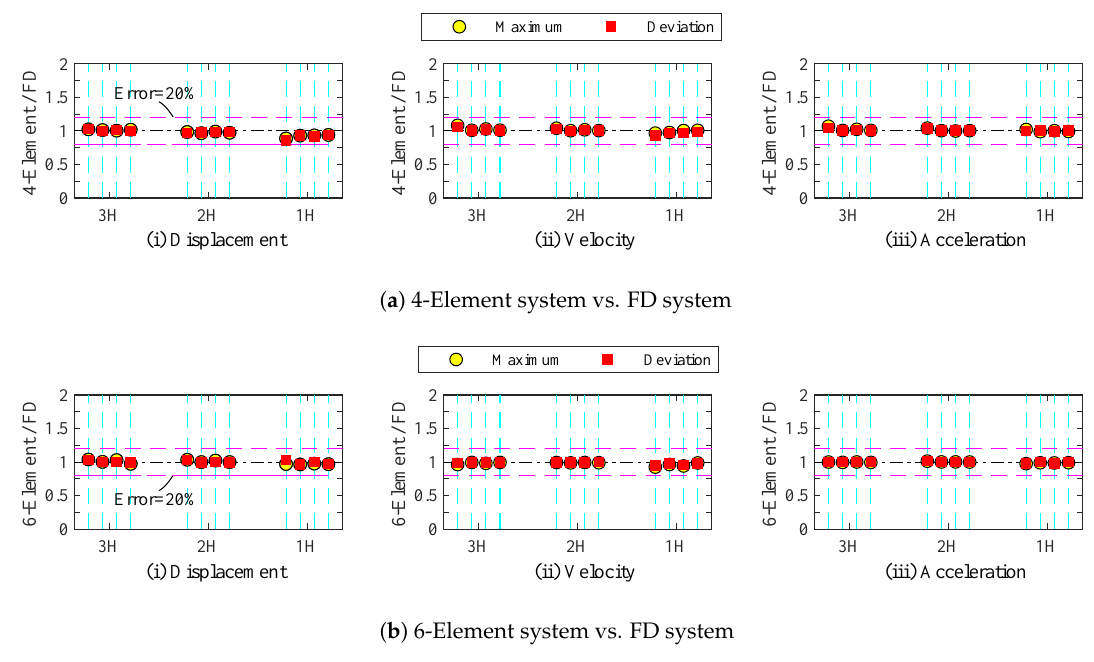
Figure 24. Ratio of wind-induced responses (across-wind): (HH, SH, HS, SS from left to right of each